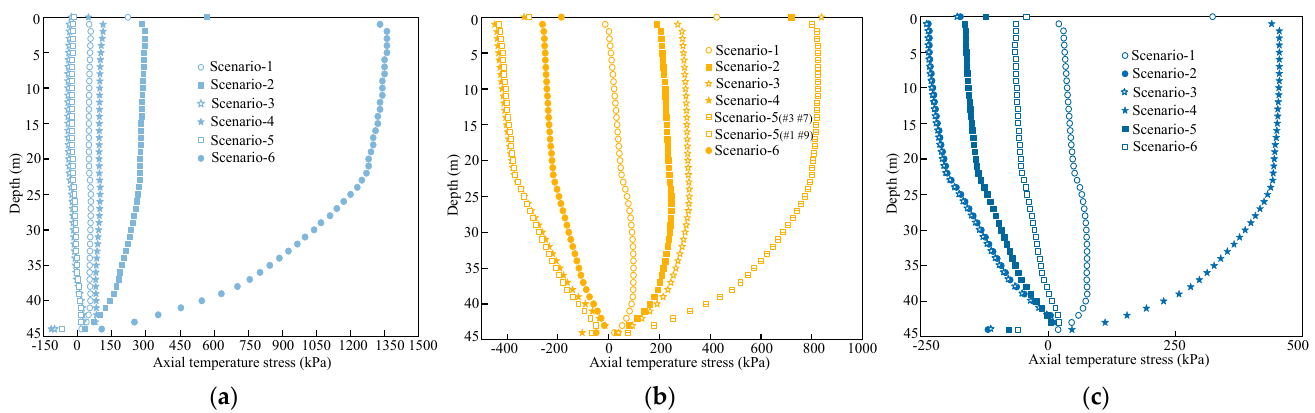
Figure 14. Distribution of temperature stress of different piles in different scenarios. ( a ) Center pile (Pile 5). ( b ) Corner pile (Pile 1/3/7/9). ( c ) Side pile (Pile 2/4/6/8).